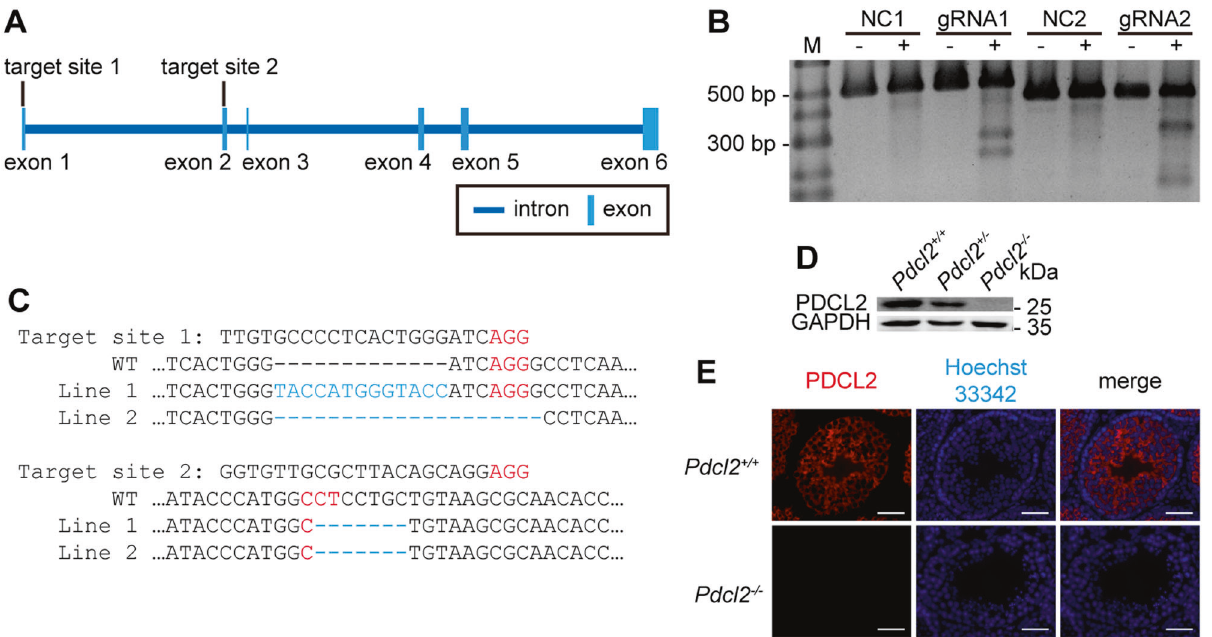
Fig. 2 Generation of Pdcl2 knock-out mice using CRISPR/Cas9. A Schematic representation of the gRNA target sites of the Pdcl2 gene. Exon 1 is the noncoding region. Exon 2 is the beginning of the coding region. B Ef fi cacy of CRISPR/Cas9 with the two designated gRNA. V6.5 mouse embryonic stem cells were transfected with different gRNA-containing pX330 or GFP plasmid as a negative control. Targeted genomic region was PCR ampli fi ed and then digested by T7 Endonuclease I. M, molecular weight markers. NC, negative control. C Genotype of the Pdcl2 knock-out mice. Both gRNAs were used simultaneously, generating indels in both gRNA target sites in the Pdcl2 knock-out mice. Indels were generated as highlighted in blue. Protospacer adjacent motifs (PAM) were labeled in red. Minus signs were used to fi ll in the blanks of the alignment. Apostrophes replaced the omitted sequences due to the demonstration clarity purpose. D , E Con fi rmation of PDCL2 de fi ciency in Pdcl2 − / − mice. D Representative western blot analysis of testes lysate. GAPDH was used as loading control. E